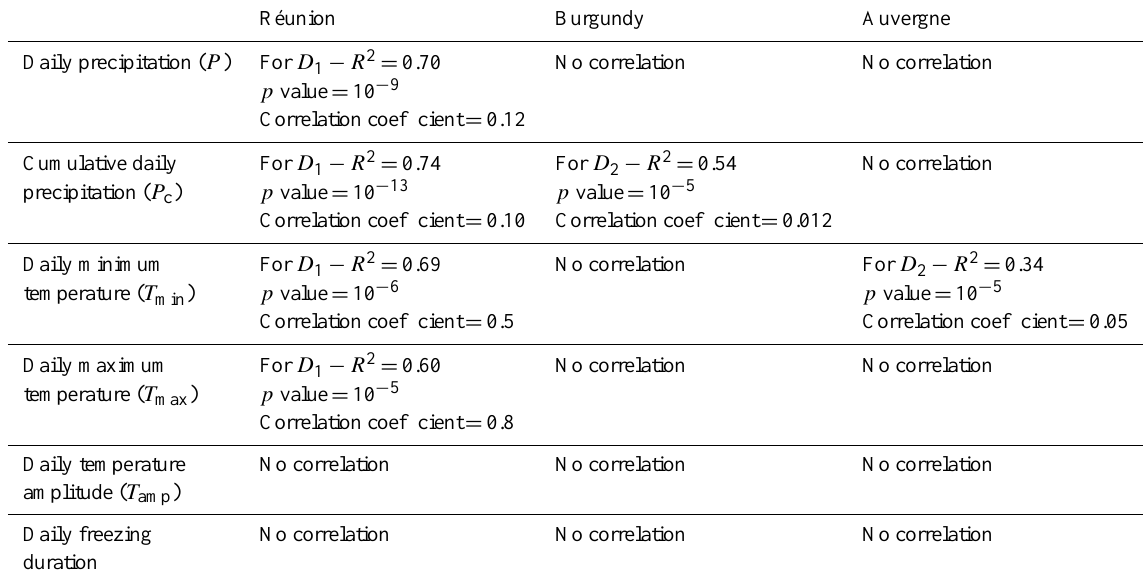
Table 5. Correlations between the chosen meteorological factors and the daily number of rockfalls; results obtained with the proposed method on the real databases. Only the maximum correlations are presented